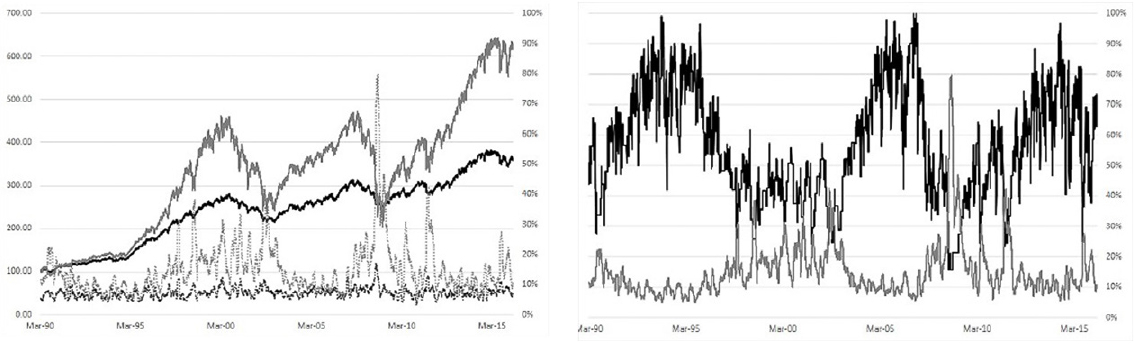
Figure 6. Comparative results for the TVS VIX portfolio and the S&P 500 Note: The left side presents the path of TVS VIX (solid black line) and of S&P 500 (solid gray line), and the TVS VIX rolling standard deviation (dotted black line) and the S&P rolling standard deviation (dotted gray line). The right side presents how the equity exposure of the TVS VIX (solid black line) changes with respect to the volatility of the S&P 500 (solid gray